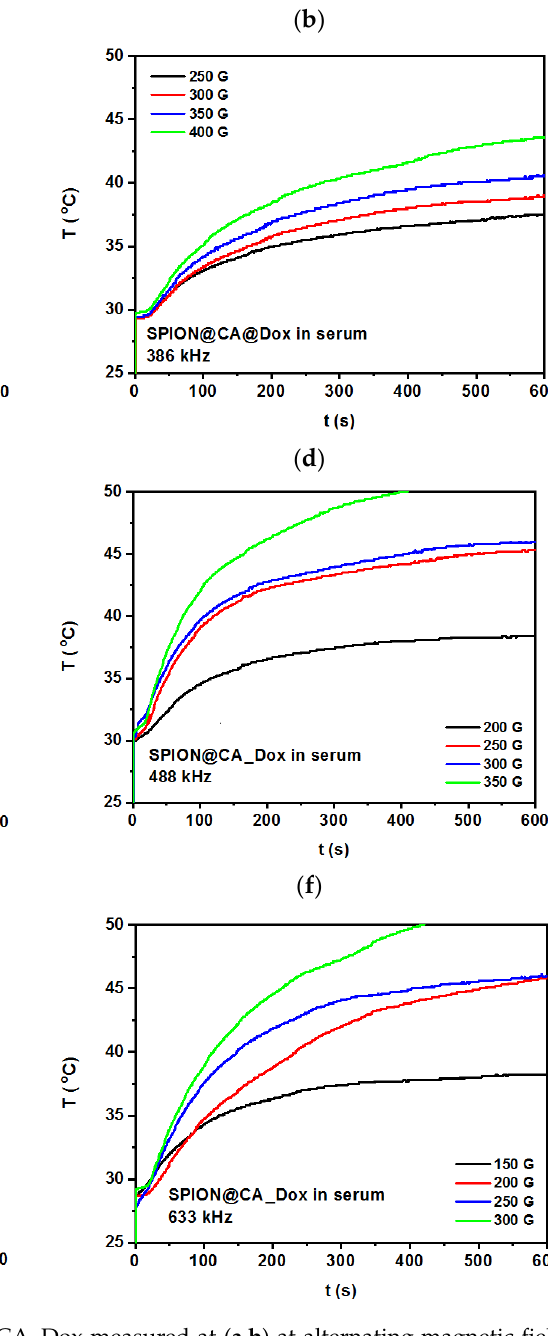
Figure 8. Temperature-time profile for hybrid SPION@CA_Dox measured at ( a , b ) at alternating magnetic field about 386 kHz, ( c , d ) 488 kHz, and ( e , f ) 633 kHz. The left column presents results for measurements performed in the phosphate buffer pH 5.8, while the right column corresponds to the experiments performed in the human serum.